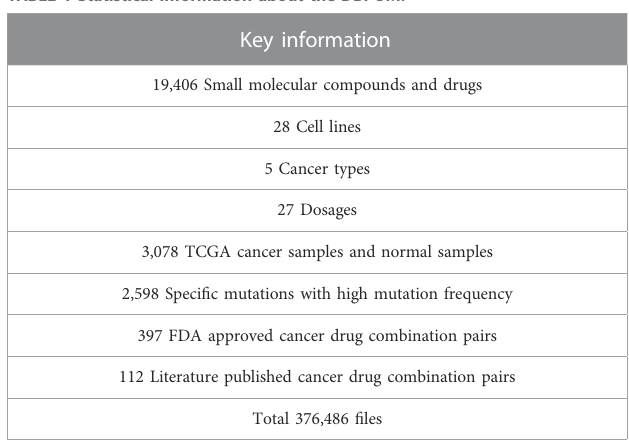
TABLE 1 Statistical information about the